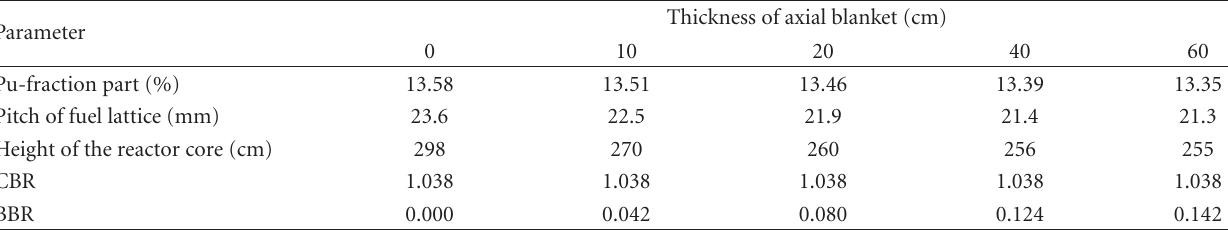
Table 6: Influence of axial blanket thickness on reactor parameters.